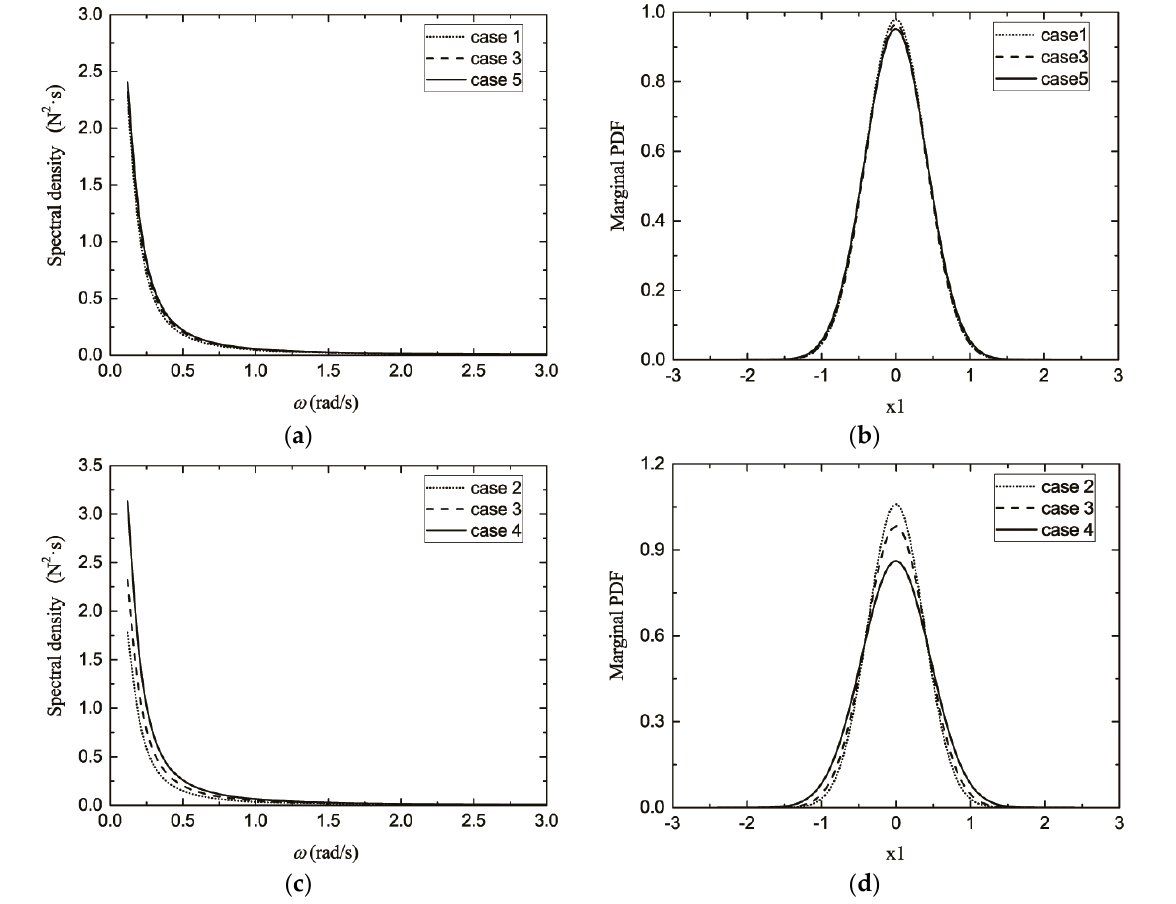
Figure 11. Relative wind excitation spectra and PDF of displacement calculated by FFT-PI for different cases: ( a ) Relative wind excitation spectral density for Case 1, 3, and 5; ( b ) PDF of displacement calculated by FFT-PI for Case 1, 3, and 5; ( c ) Relative wind excitation spectral density for Case 2, 3, and 4; ( d ) PDF of displacement calculated by FFT-PI for Case 2, 3, and 4.